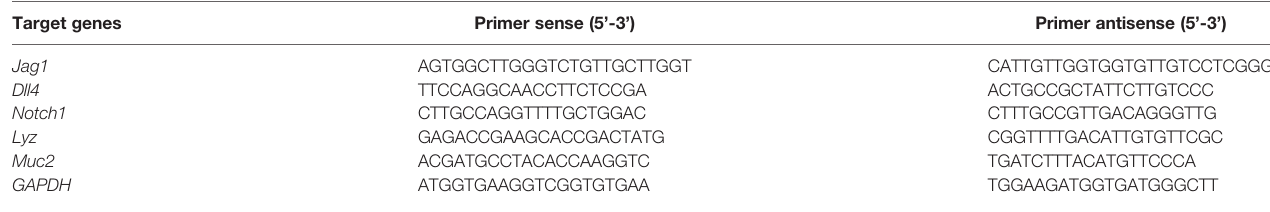
TABLE 1 | Primer sequences used for RT-qPCR. Target